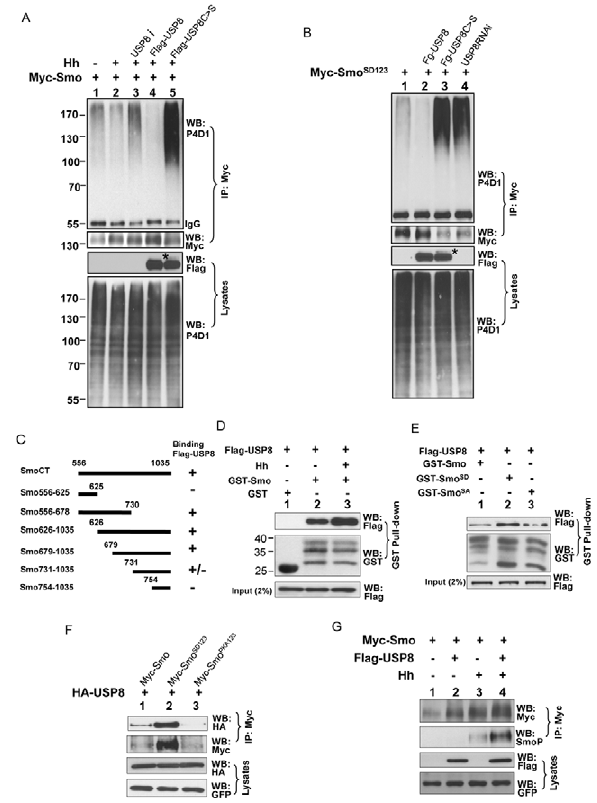
Figure 5. USP8 regulates Smo ubiquitination. (A) S2 cells transfected with Myc-Smo in combination with the indicated USP8 constructs or with USP8 dsRNA treatment were treated with Hh- conditioned medium or control medium. An immunoprecipitation assay was carried out with the indicated antibodies to examine the regulation of Smo ubiquitination by Hh or USP8. In the above experiments, GFP served as a transfection and loading control. (B) S2 cells were transfected with Myc-Smo SD123 alone or in combination with either Flag-USP8, Flag-USP8C . S, or USP8 dsRNA treatment. Cell extracts were immunoprecipitated with the anti-Myc antibody and subjected to a Western blot with the anti-Ub P4D1 antibody to detect ubiquitinated Smo (top panel), or with the anti-Myc antibody to detect the expression of Myc-Smo SD123 (upper-middle panel). Cell lysates were also subjected to a direct Western blot with the anti-Flag antibody to detect USP8 or USP8C . S overexpression (lower-middle panel) or with the anti-Ub P4D1 antibody to detect the overall level of Ub (bottom panel). The asterisk indicates a possible modification of USP8C . S. USP8 reduced Smo SD123 ubiquitination, whereas USP8C . S